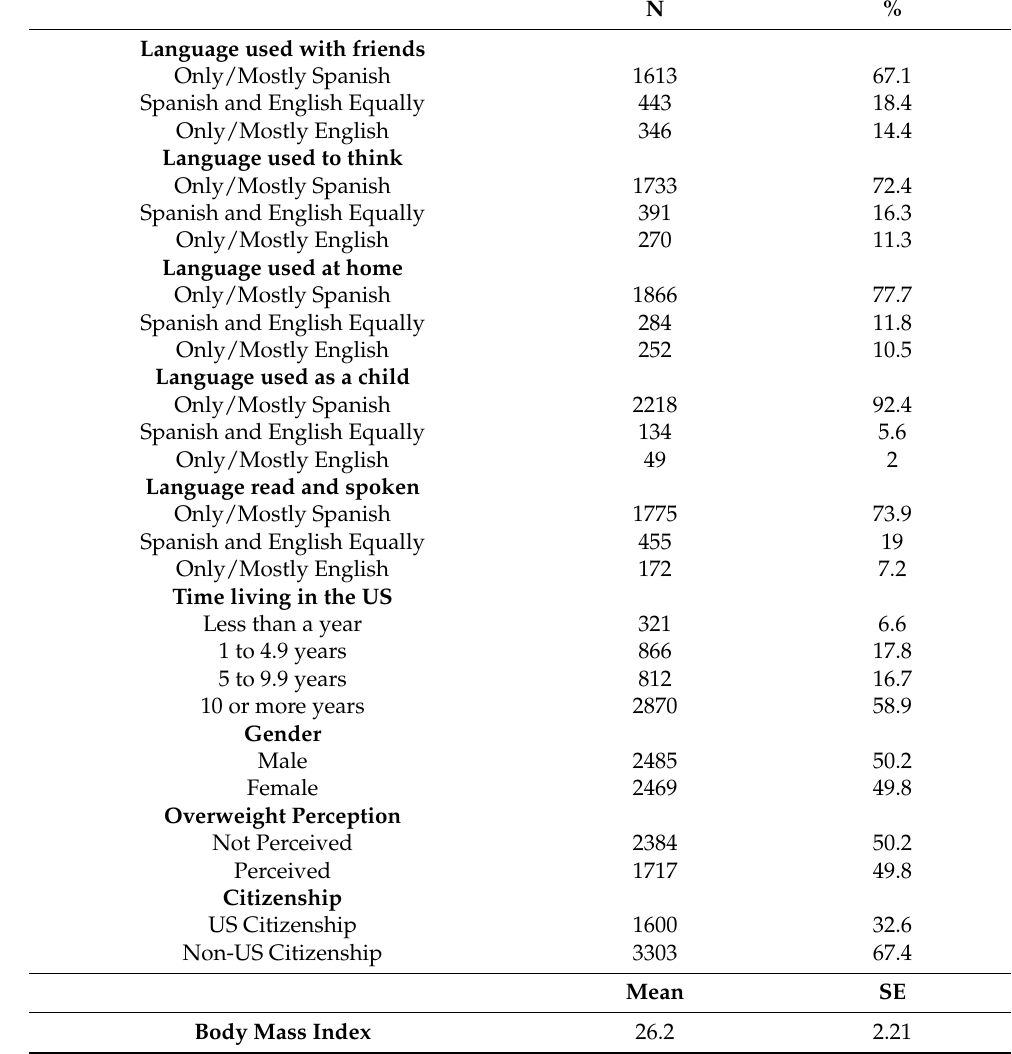
Table 1. Sample statistics (N =